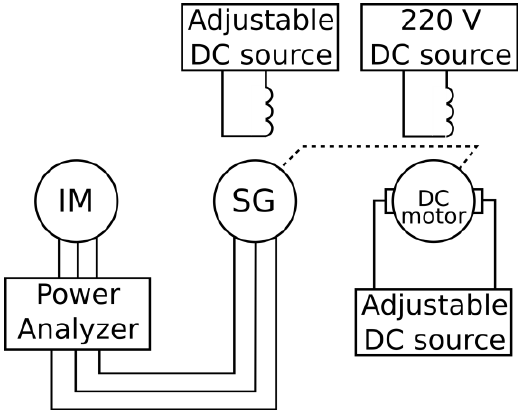
Figure 6. Block diagram of the synchronous-generator-supplied induction motor.